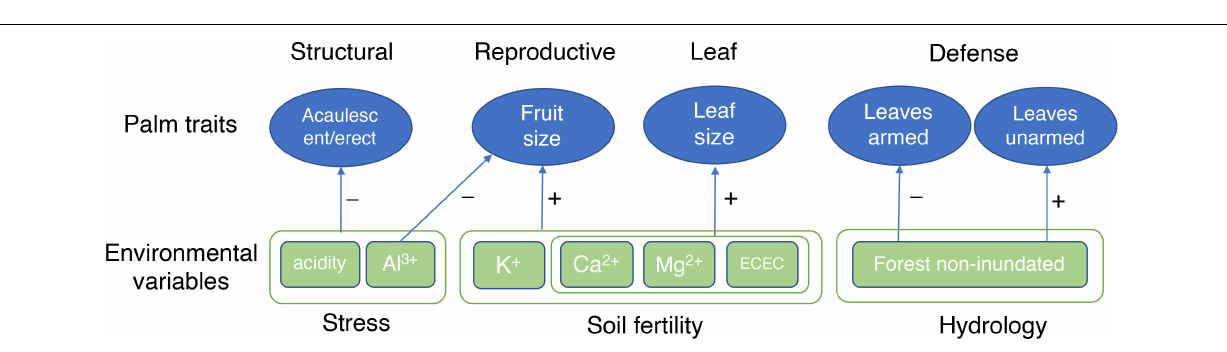
FIGURE 5 | Summary of the palm traits-environment correlations for the 116 palm species present in western